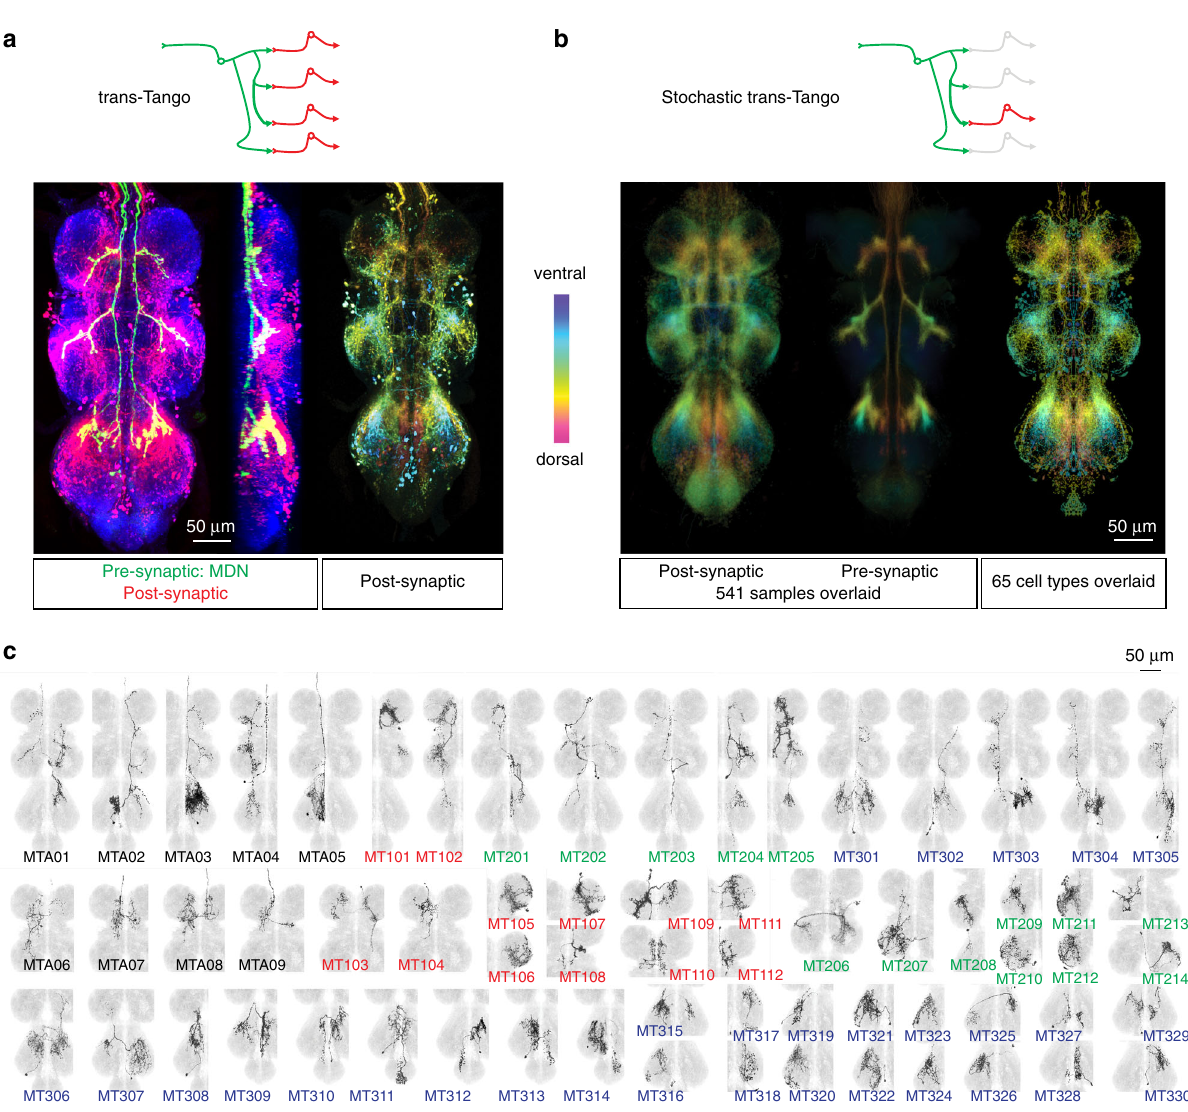
Fig. 2 Trans-Tango reveals cells postsynaptic to MDNs. a Top, schematic of trans-Tango labeling, showing target cell in green and trans-synaptically labeled cells in red. Bottom, an example of trans-Tango labeling of cells postsynaptic to MDNs, targeted with MDN-1-GAL4 . Left, maximum projection confocal image of the VNC, shown in ventral and lateral views, with MDN axons in green (anti-GFP), trans-Tango labeled cells in red (anti-HA), and all synapses in blue (anti-Bruchpilot, nc82). Right, the same sample registered onto a standard VNC template, with the trans-Tango channel shown as a color- coded maximal intensity projection (colorMIP) in which color encodes the z-section in which the maximum occurs. b Top, schematic of stochastic trans- Tango labeling. Bottom left and middle, standard deviation projections of colorMIP images of the post- and presynaptic channels, respectively, of 541 stochastic trans-Tango samples. Bottom right, standard deviation projection of 65 types of segmented neurons and their mirror images. c Segmented MT cell types from stochastic trans-Tango dataset, shown as registered maximum intensity projections overlaid on the JRC2017 template VNC. Cell-type designations are colored to indicate ascending neurons (black), and interneurons with soma located in either T1 (red), T2 (green), or T3 (blue). Each cell type is given a provisional name beginning with “ MT ” ( “ MDN trans-Tango ”